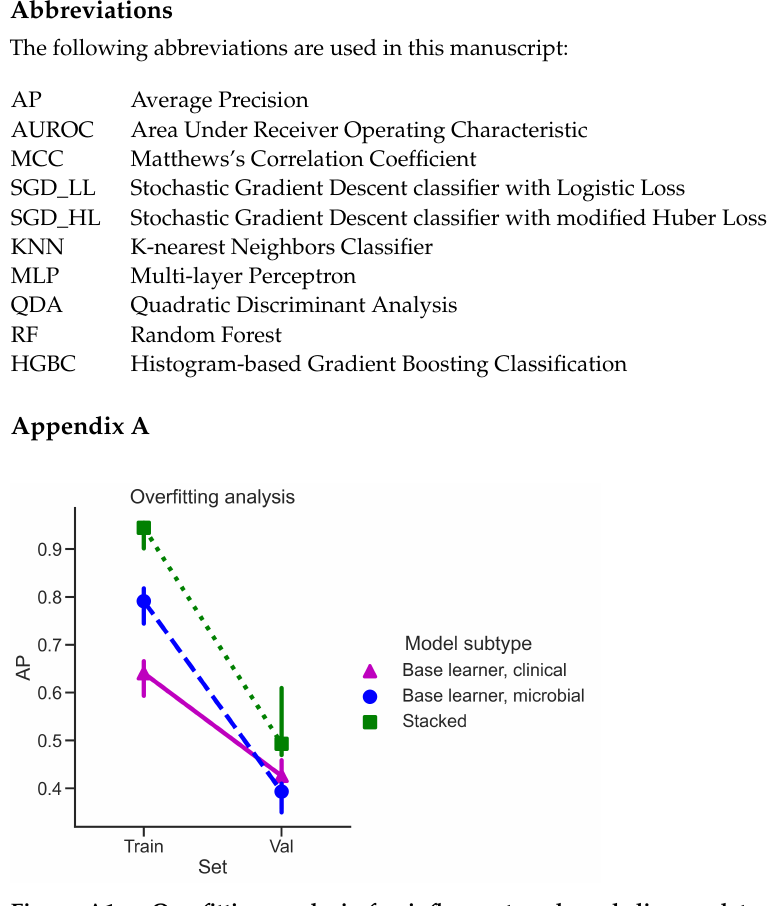
Figure A1. Overfitting analysis for inflammatory bowel disease dataset comparing stacked model’s and base learners’ performance separated by view during cross-validation. Point val- ues refer to median AP values and bars refer to estimated confidence intervals. Values for base learners trained on microbial view are aggregated together without distinction with regard to an individual base